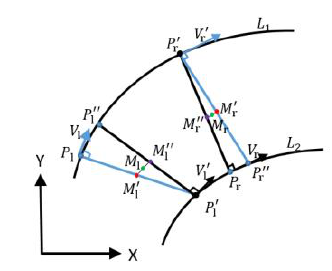
Figure 1 Interpolate of central axis points